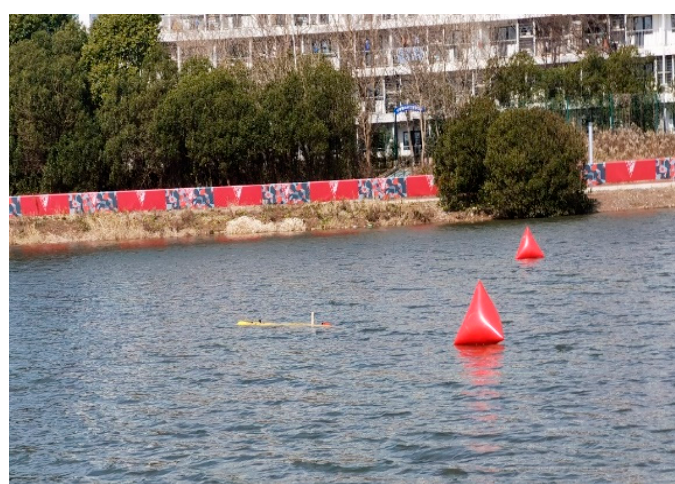
Figure 28. AUV standby in dock.